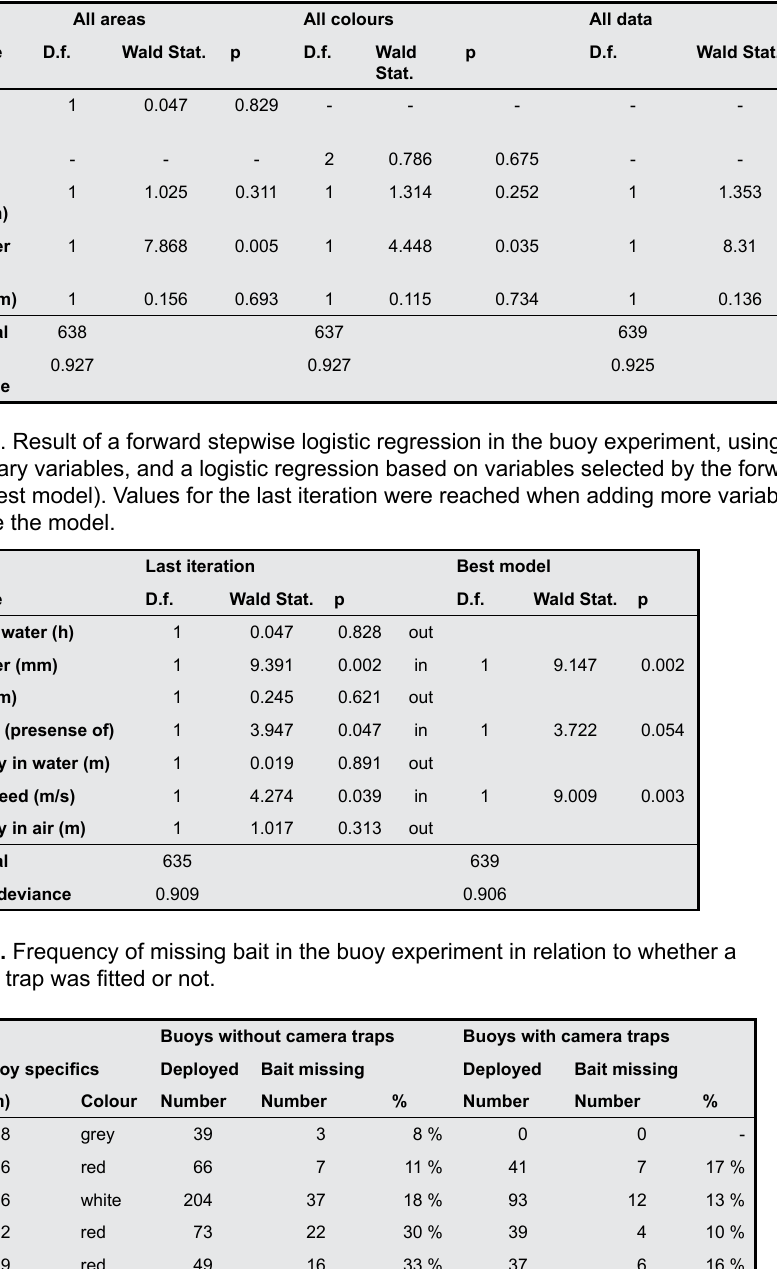
Table 4. Result of logistic regression with primary variables in the buoy experiment, using three dif- ferent datasets: All areas (Colour excluded), All colours (Study area excluded) and All data (Colour and Study area excluded).